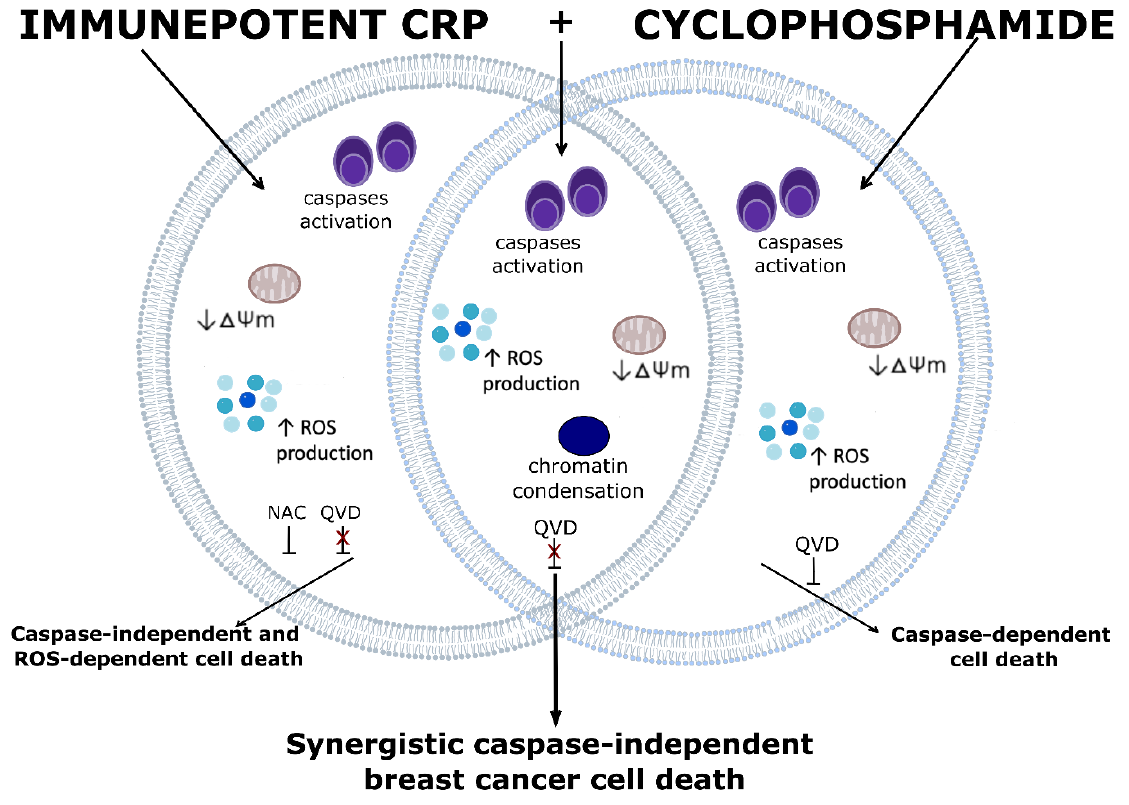
Figure 6: ICRP+CTX cell death depiction in breast cancer cells. ICRP induces caspase-independent and ROS-dependent breast cancer cell death, whereas CTX induces caspase-dependent breast cancer cell death. Here we showed that ICRP in combination with CTX induces synergistic cell death mani- fested with morphological changes and it involves mitochondrial alterations such as the loss of mito- chondrial membrane potential and reactive oxygen species (ROS) production, and even though caspase activation occurs, ICRP+CTX cell death is caspase-independent in all the breast cancer cells